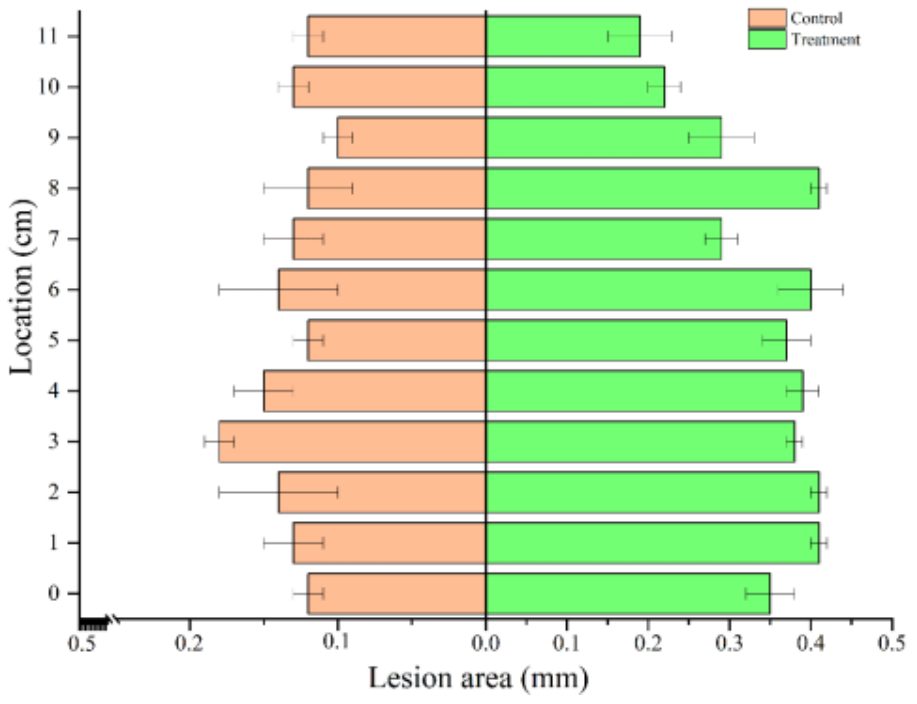
Figure 4. Diseased areas on cross-section roots of poplar. Values and errors are the averages of thre trials, (one-way analysis of variance, ANOVA, p < 0.05).